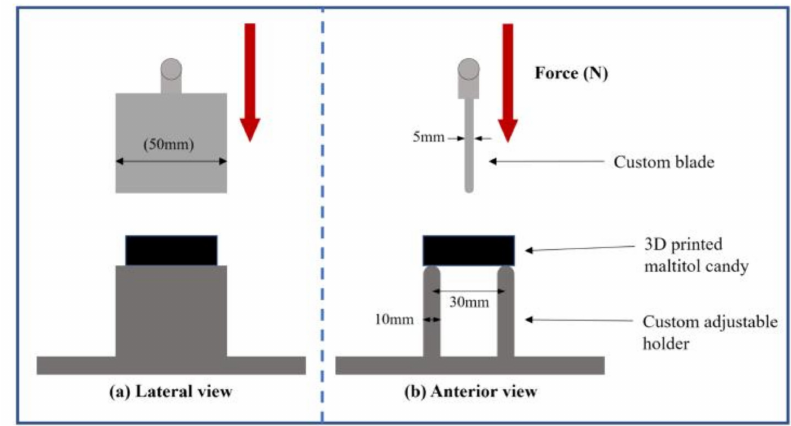
Figure 4. Compression